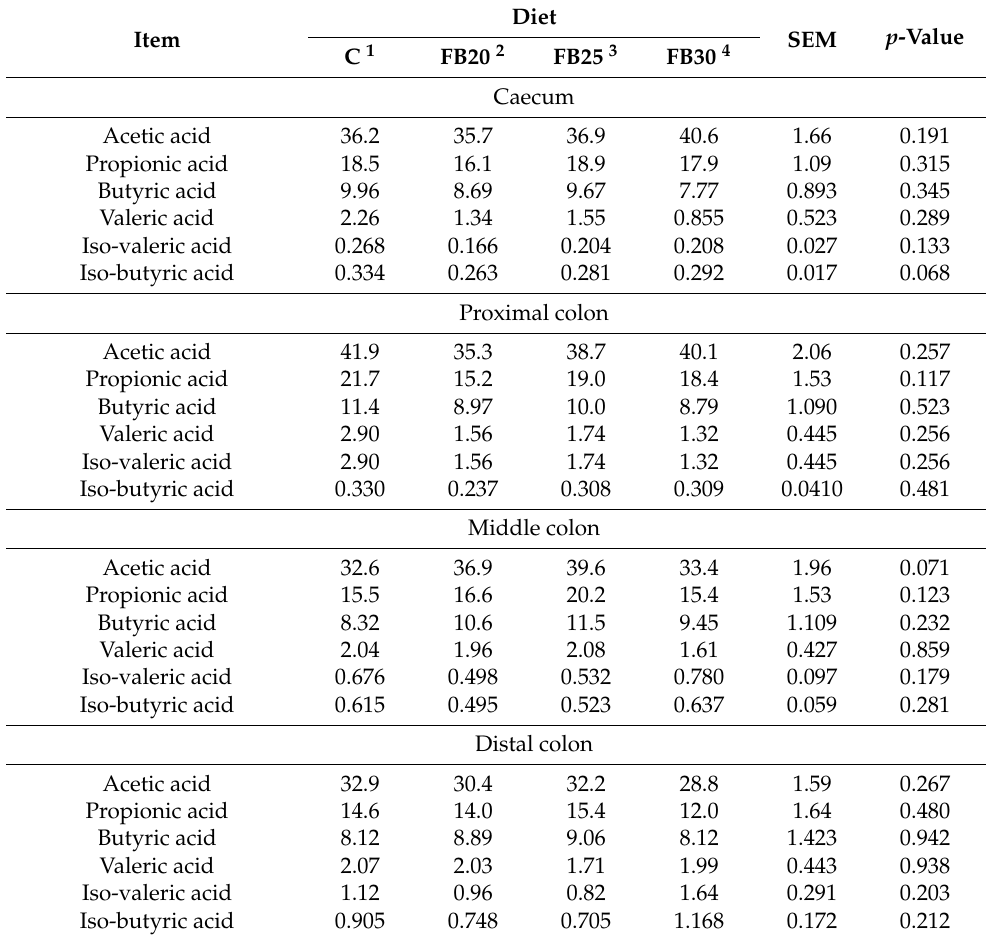
Table 4. SCFA concentration in the large intestine of pigs fed diets with extruded faba bean seeds, µ mol/g digesta.